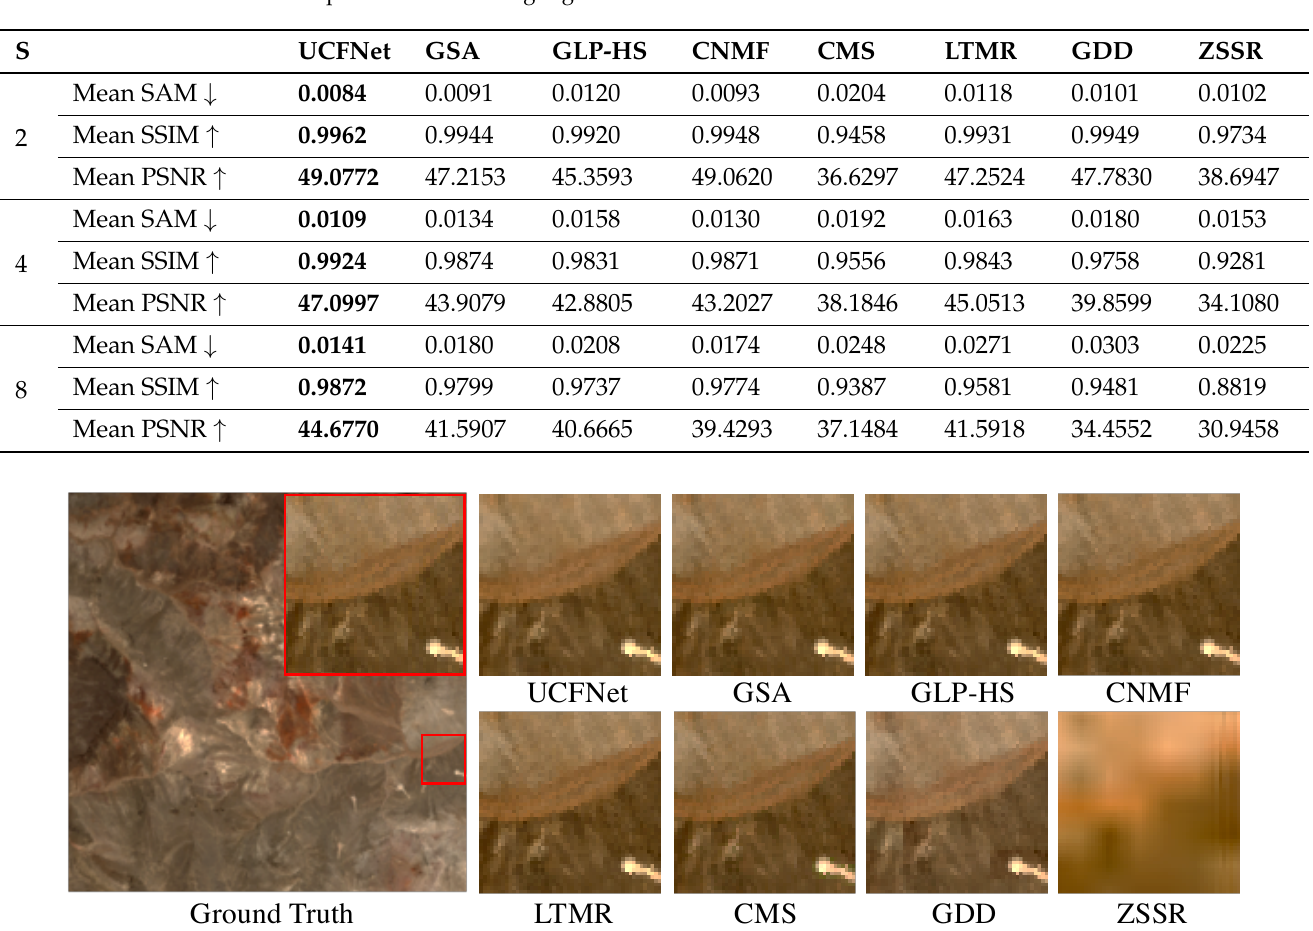
Table 1. Quantitative performance comparison of different algorithms on dataset AVIRIS-NG-Cuprite. The up-arrow means the higher the value, the better the performance. The down-arrow means the lower the value, the better the performance. S denotes the value of the up-scale factor. The best performances are highlighted in bold.